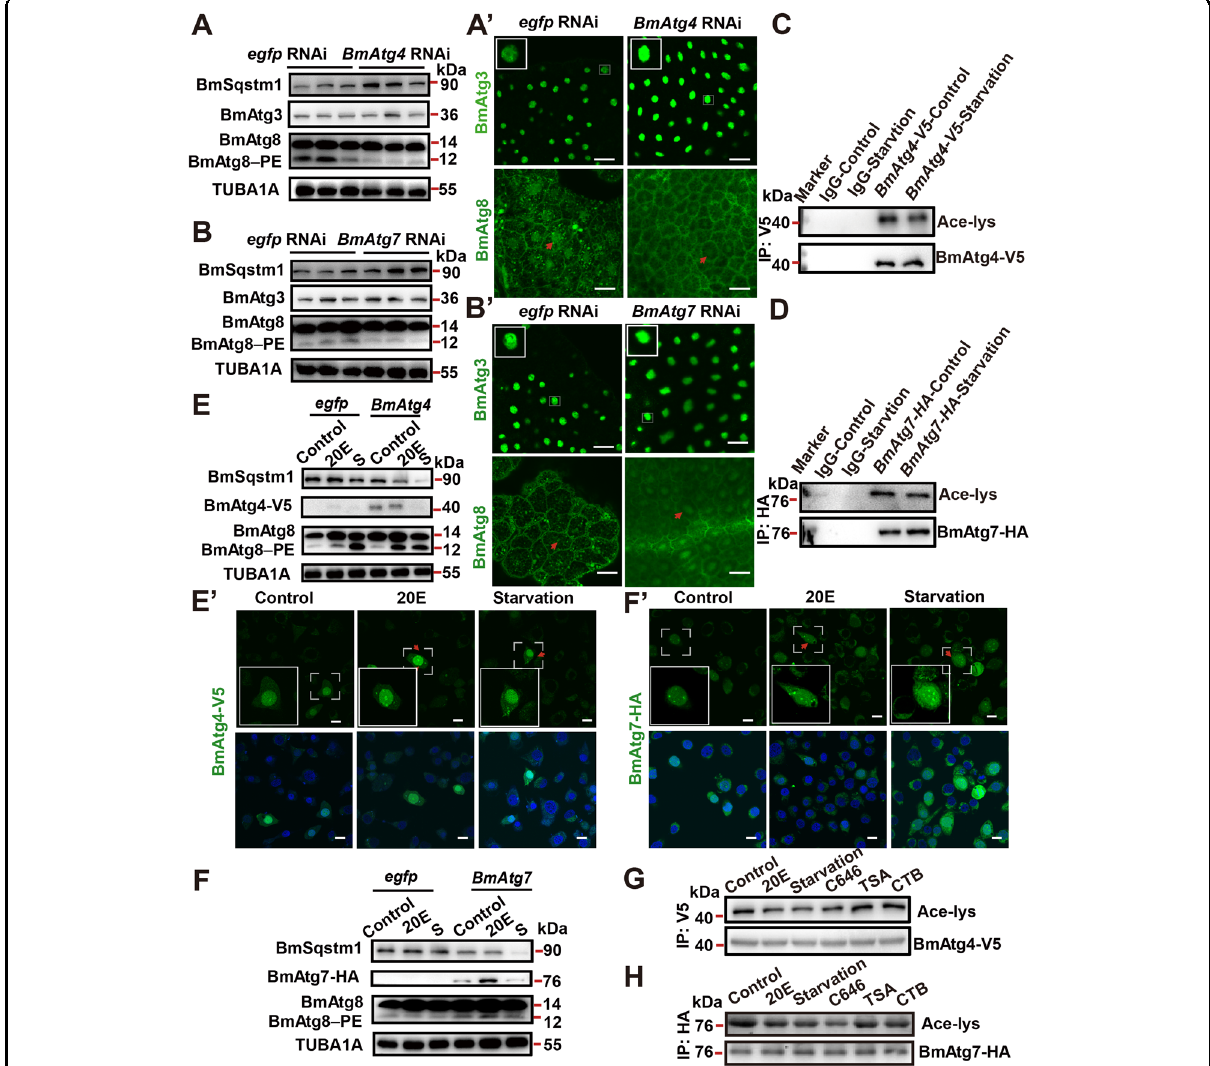
BmAtg3, and BmAtg8 ( A ) and immuno fl uorescent staining of BmAtg3 and BmAtg8 (A ’ ) in the fat body after BmAtg4 RNAi for 24 h. Scale bar: 10 µm. B – B ′ Protein levels of BmSqstm1, BmAtg3, and BmAtg8 ( B ) and immuno fl uorescent staining of BmAtg3 and BmAtg8 (B ′ ) in the fat body after BmAtg7 RNAi for 24 h. Scale bar: 10 µm. C Acetylation levels of BmAtg4-V5 after starvation for 4 h. D Acetylation levels of BmAtg7-HA after starvation for 4 h. E – E ′ Protein levels of BmAtg8, BmSqstm1, and BmAtg4-V5 ( E ), and immuno fl uorescent staining of BmAtg4-V5 (E ′ ) after 20E or starvation treatment for 4 h, S starvation. Scale bar: 10 µm. F – F ′ Protein levels of BmSqstm1, BmAtg7-HA, and BmAtg8 ( F ), and immuno fl uorescent staining of BmAtg7-HA (F ′ ) after 20E or starvation treatment for 4 h. Scale bar: 10 µm. G Acetylation levels of BmAtg4-V5 after 5 μ M 20E, starvation, 800 nM C646, 20 µM TSA, or 20 µM CTB treatment for 6 h in BmN cells. H Acetylation levels of BmAtg7-HA after 5 μ M 20E, starvation, 800 nM C646, 20 µM TSA, or 20 µM CTB treatment for 6 h in BmN